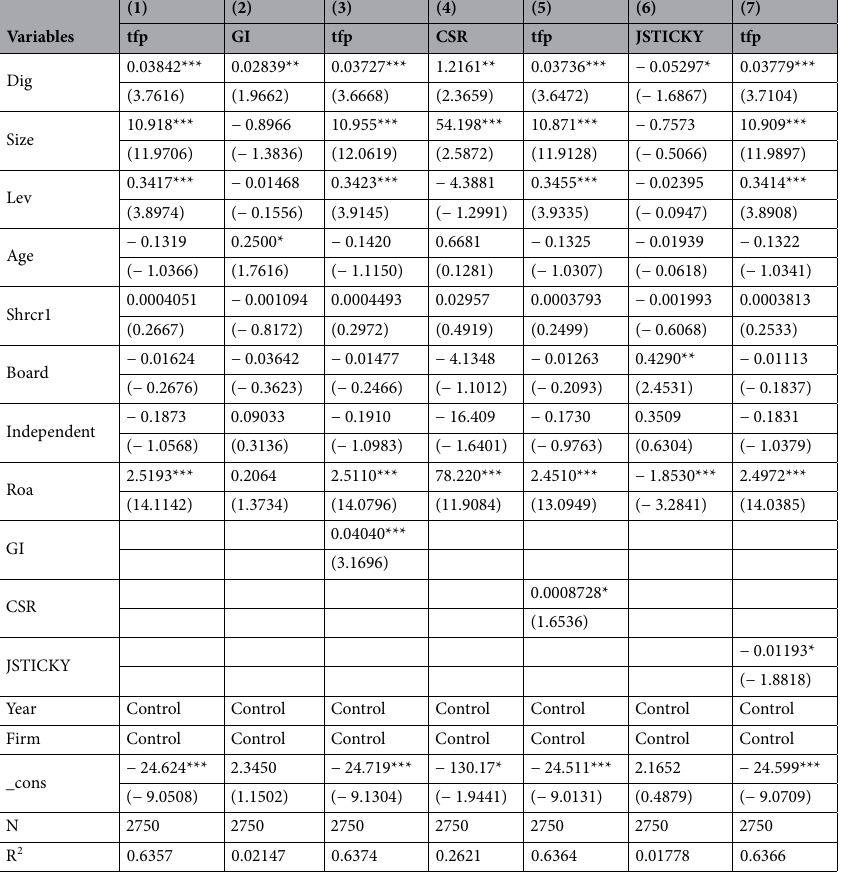
Table 9. Regression results of intermediate effects. T-statistics are shown in parentheses. ***, ** and * indicate 1%, 5% and 10%